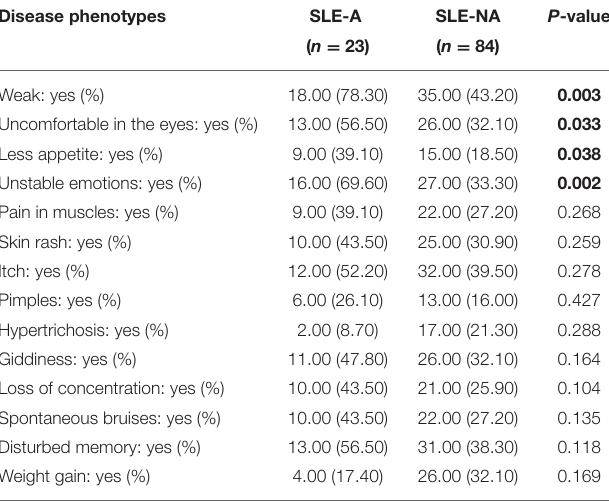
TABLE 2 | Disease phenotypes characteristics of SLE patients. Disease phenotypes